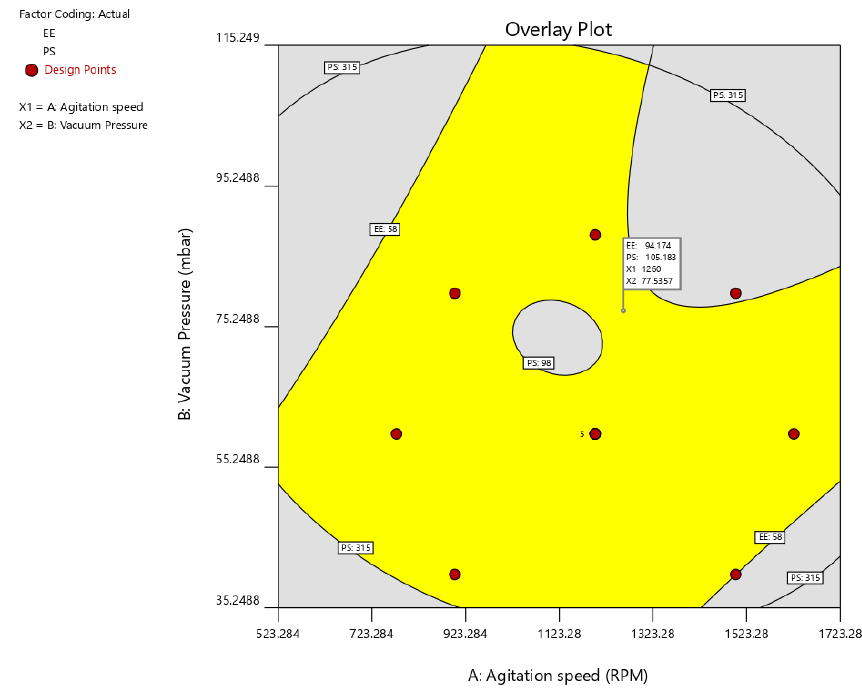
Figure 4. Overlay plot of optimization result.